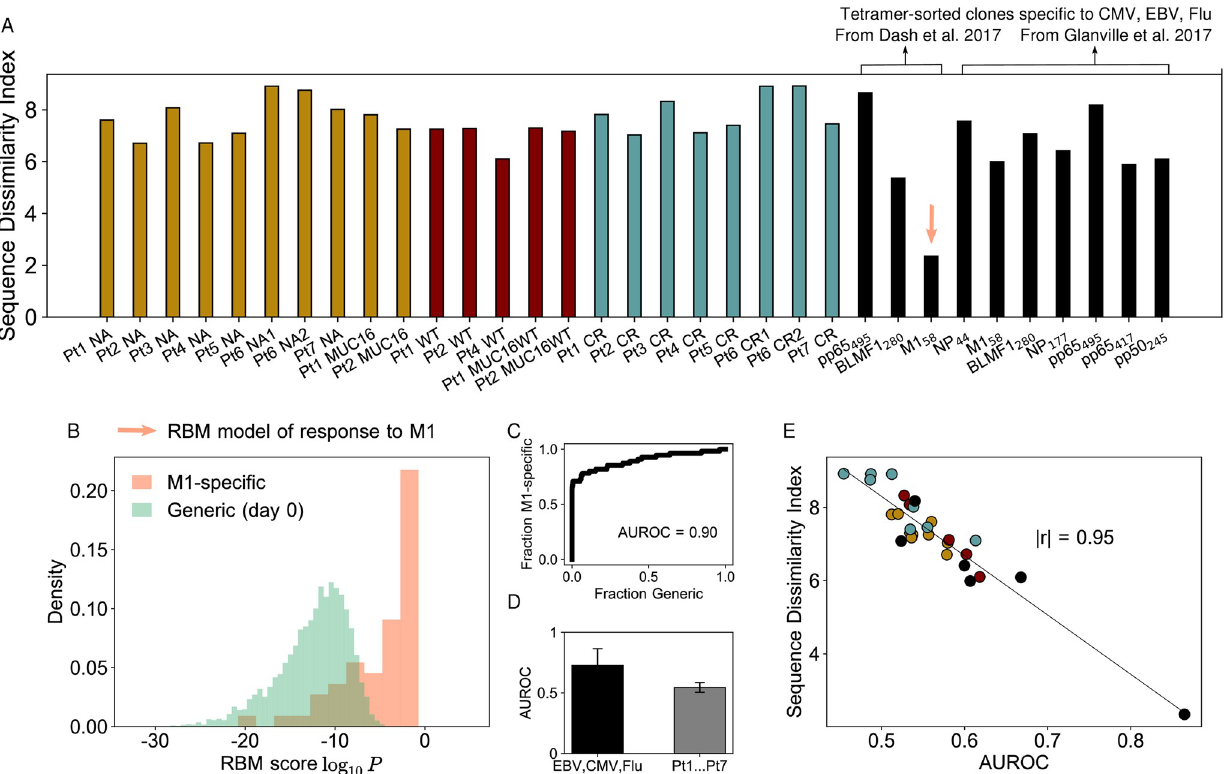
Fig 7. Diversity among responding clones and model’s predictive power. A: The sequence dissimilarity index (a modified TCRdiv diversity index, see Materials and methods) calculated for the pool of expanded clones in the Pt1, ... ,Pt7 assays from [16]. The dissimilarity index values lie in a range comparable only to the most diverse epitope-specific human repertoire of tetramer-sorted TCRs from Dash et al. [17] and Glanville et al. [22] (black bars), see also Fig 6. B: Probabilistic scores from the RBM (trained on the M1-specific repertoire from [17]) evaluated for a testing set of M1-specific CDR3 and generic CDR3 randomly drawn from the day 0 of Pt1, ... ,Pt7 samples. The model’s ability to predict M1-specific clones is quantified by the high AUROC value (C). D: AUROCs for models trained on lower-diversity repertoires (tetramer-sorted TCR data from [17, 22], black bar) are in average higher than for the Pt1, ... ,Pt7 datasets (gray bar). Bar plots give the average AUROC and its standard deviation. AUROC values are estimated by a leave-one-out 5-fold validation protocol (see Materials and methods). E: AUROC for the tetramer-sorted and Pt1, ... ,Pt7 datasets is inversely correlated with the sequence dissimilarity index, Pearson correlation r of magnitude | r | = 0.95, p -value for testing non-correlation = 2.53 × 10 − 14 (| r | = 0.87 and p -value = 1.9 × 10 − 7 considering only Pt1, ... ,Pt7 datasets). D-E show that the predictive power of sequence-based models is degraded for high-diversity repertoires. We discarded from the AUROC test of B-E the pools of responding clones consisting of fewer than 100 sequences (Pt6 NA1, BMLF1 280 and pp65 495 from [17], NP 44 and pp65 417 from